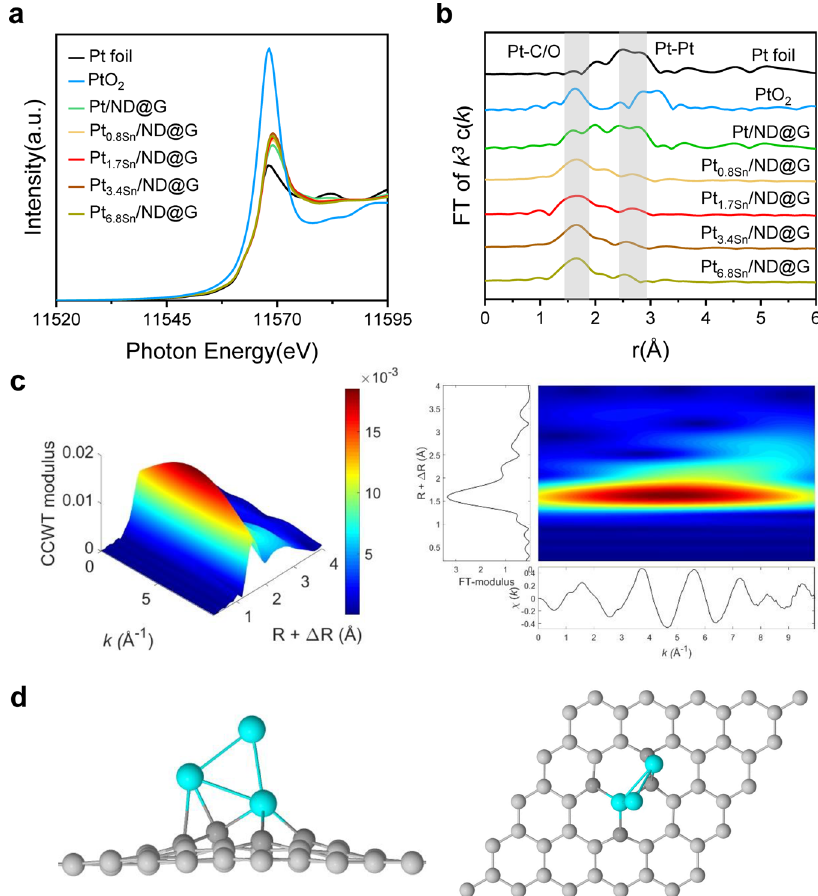
Fig. 2 Synchrotron XAFS measurements of catalysts. a Pt L 3 XANES spectra of above as-prepared catalysts, Pt foil and PtO 2 . b k 3 -weighted EXAFS spectra of above as-prepared catalysts, Pt foil and PtO 2 . c WT analysis of Pt 1.7Sn /ND@G. d Optimized structure of Pt 3 cluster embedded into graphene (Pt 3 -Gr, through Pt − C bond) from top and side views.